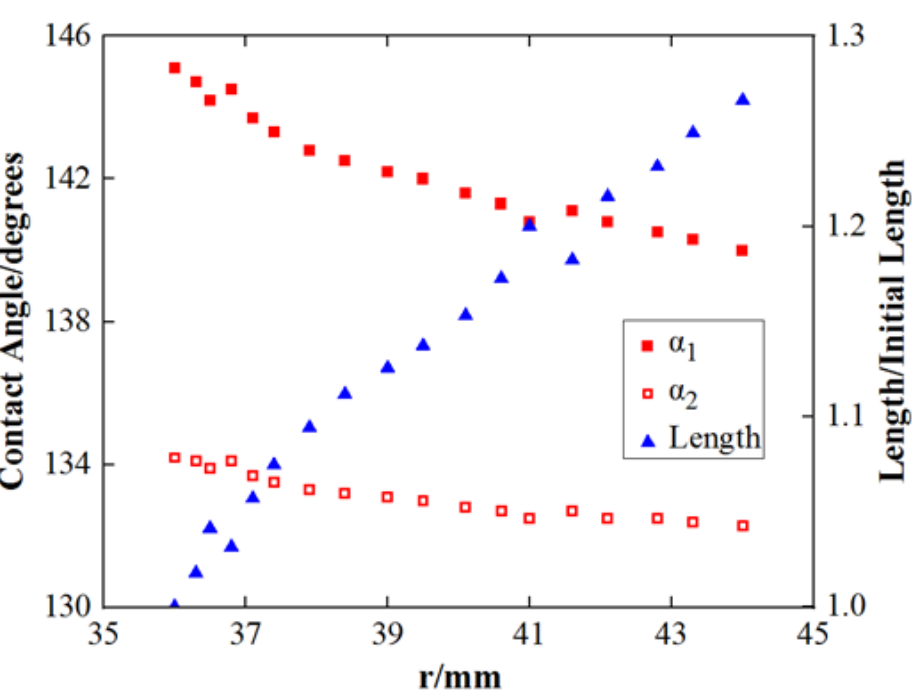
Figure 5. The experimentally observed change in the transient contact angles ( α 1 , α 2 ) and the length ratio of the contact line ( a = 1.061 mm/rad, n = 1000 rpm, D = 0.3 mm, µ o = 12.60 mPa · s).